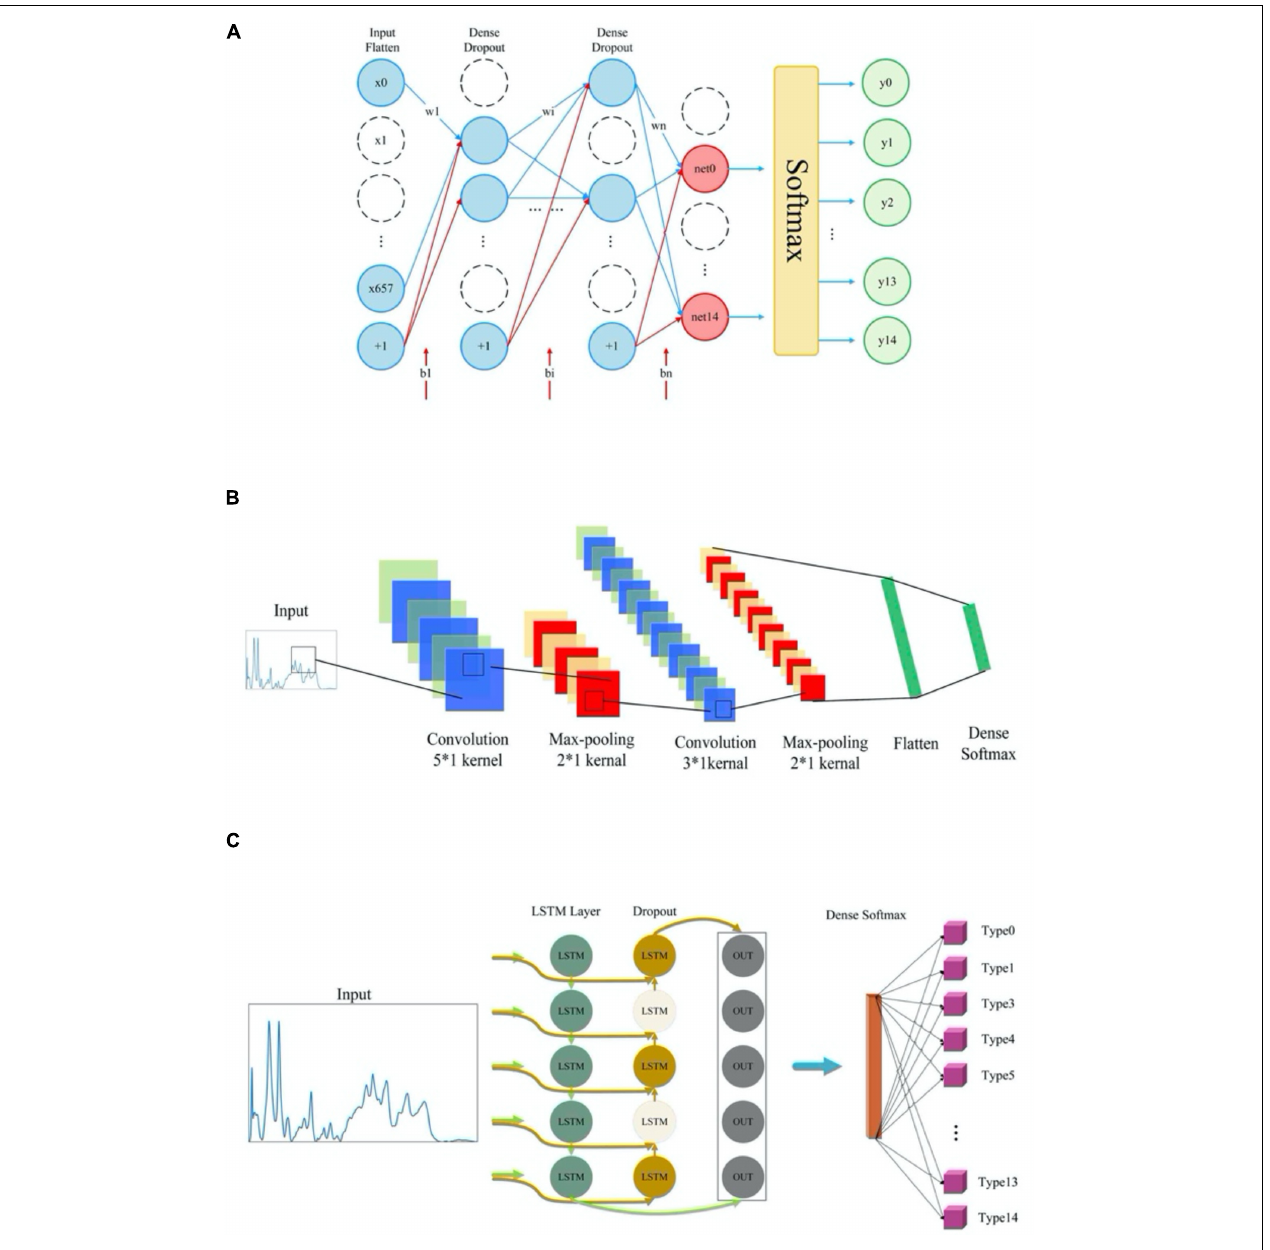
FIGURE 1 | Schematic illustration of the network structures of deep learning algorithms. (A) Multi-layer perceptron model architecture. (B) Convolutional neural network (CNN) model architecture. (C) Network structure of three recurrent neural networks (RNN)